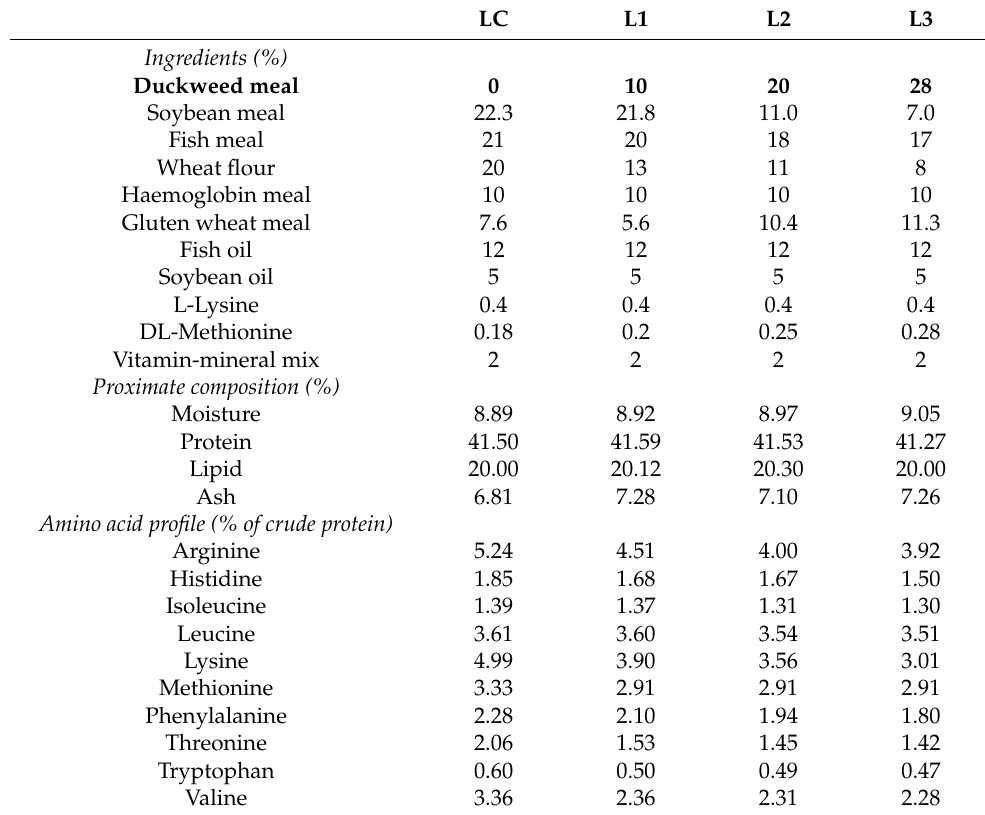
Table 4. Formulation and proximate composition of the control diet without including duck- weed meal (LC), and L1, L2 and L3 diets, with different inclusion of duckweed meal (10%, 20%, 28%,